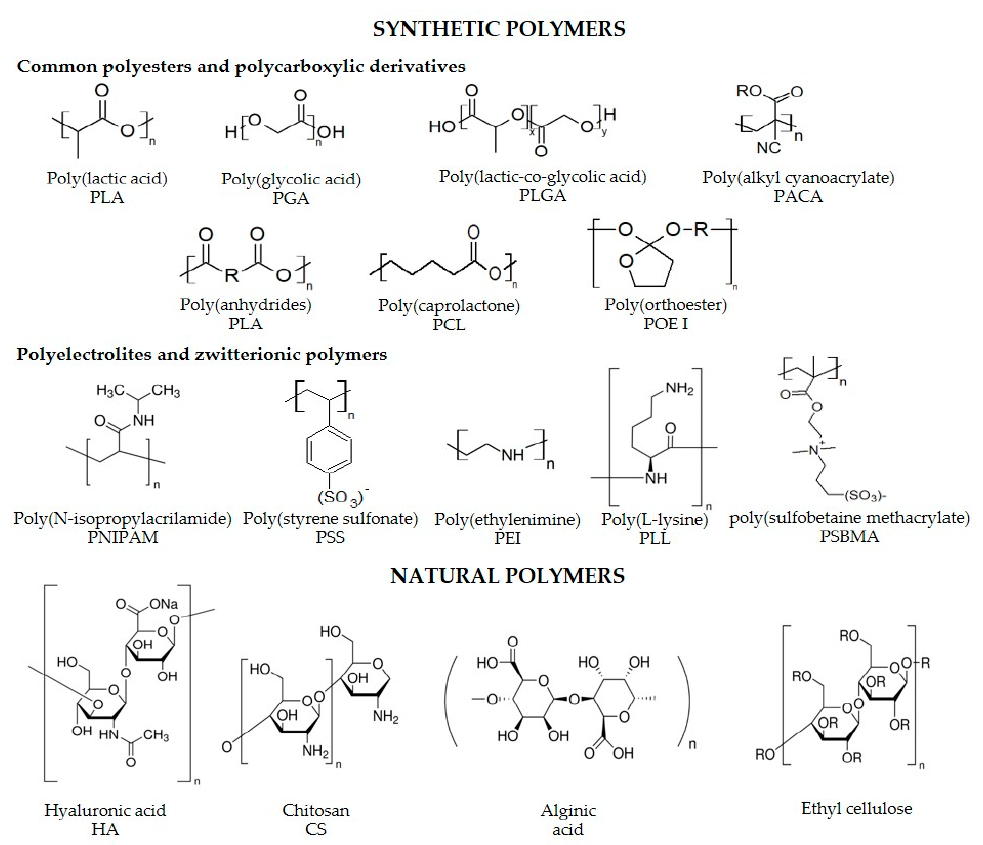
Figure 1. Polymers commonly used to manufacture PNs (polymeric nanocarriers).